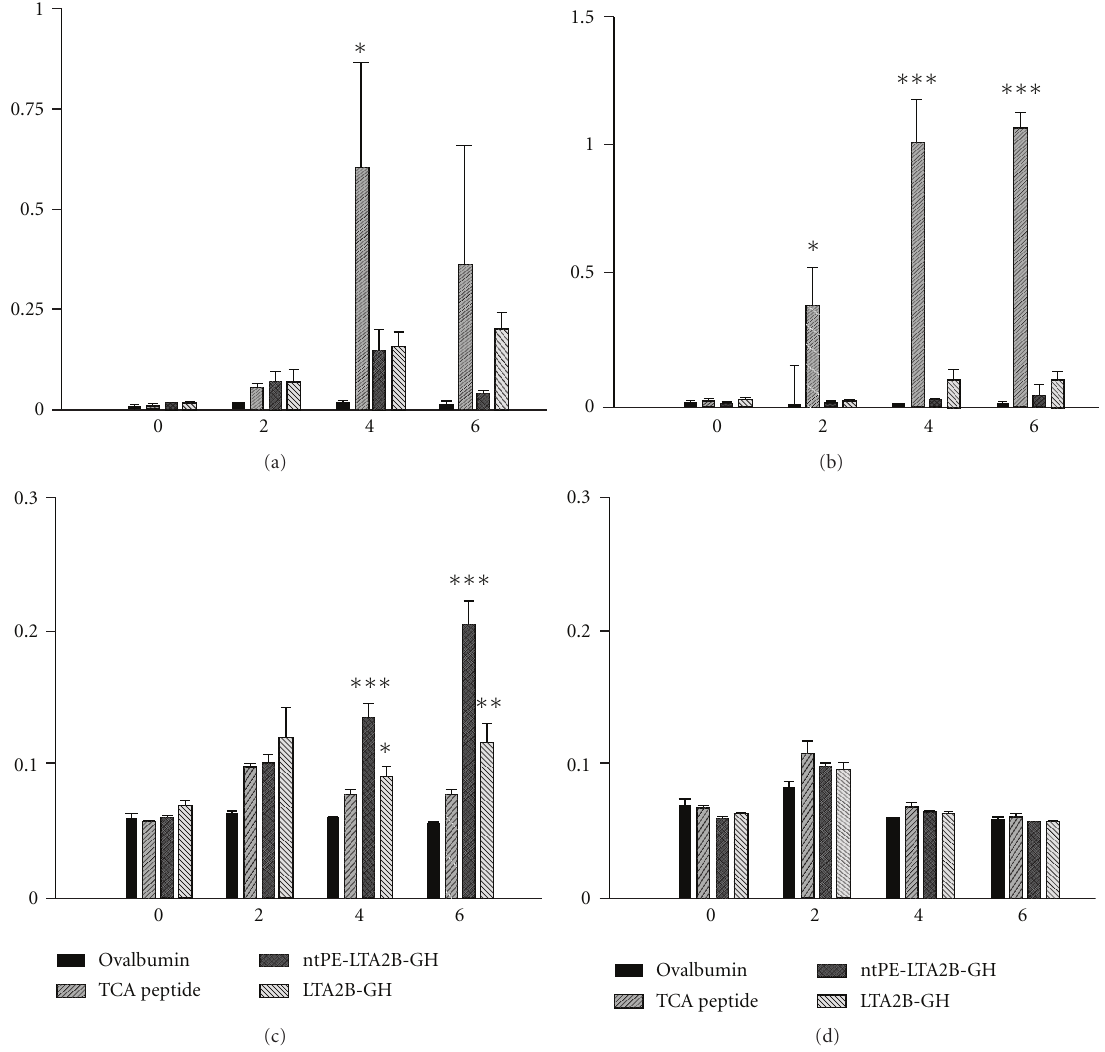
Figure 3: IgG and IgA antibody responses in serum and nasal wash samples. Pre- and postvaccination serum samples were collected every other week for six weeks from animals vaccinated i.n. (a) or s.c. (b) and were assayed for immunogen (left to right: ovalbumin, TCA peptide, ntPE-LTA2B-GH, LTA2B-GH) IgG responses by ELISA. Nasal washes were collected at the same time points and animals vaccinated i.n. (c) or s.c. (d) were assayed for immunogen IgA responses by ELISA. X -axis represents time in weeks, that is, from 0 to 6 weeks. Y -axis represents OD @ 450nm. Statistical analysis was performed using ANOVA and Tukey’s mean comparison test. Significance determined by ( ∗ ) representing P < 0 . 05, ( ∗∗ ) P < 0 . 01, and ( ∗∗∗ ) P < 0 .